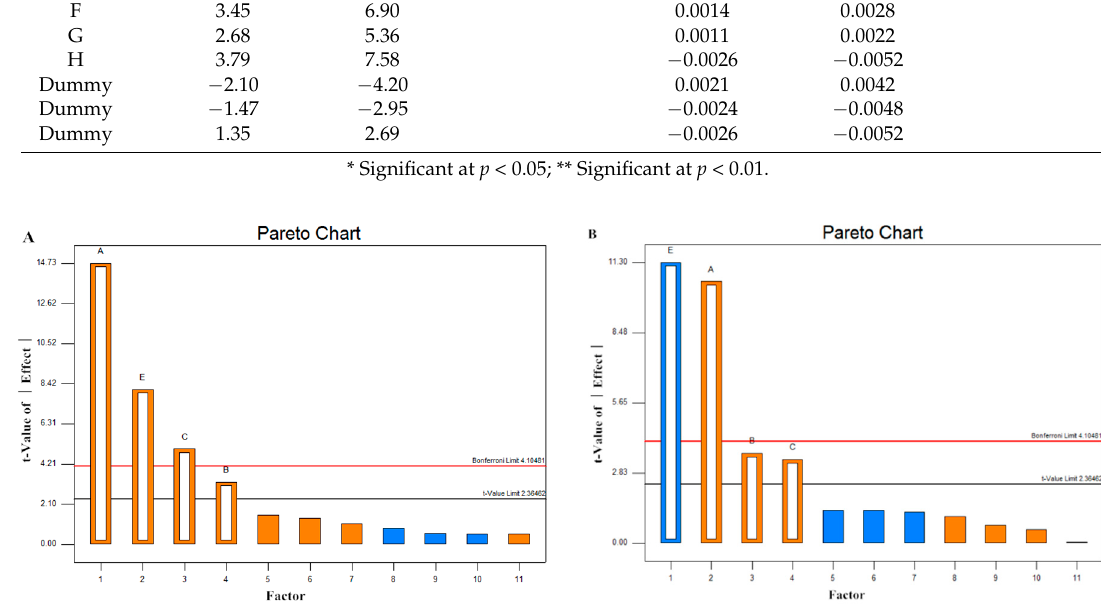
Figure 4. Pareto Chart of Plackett-Burman design for enzyme activity ( A ) and Biomass ( B ). A: κ -carrageenan, B: FOS, C: tryptone, E: NaCl.